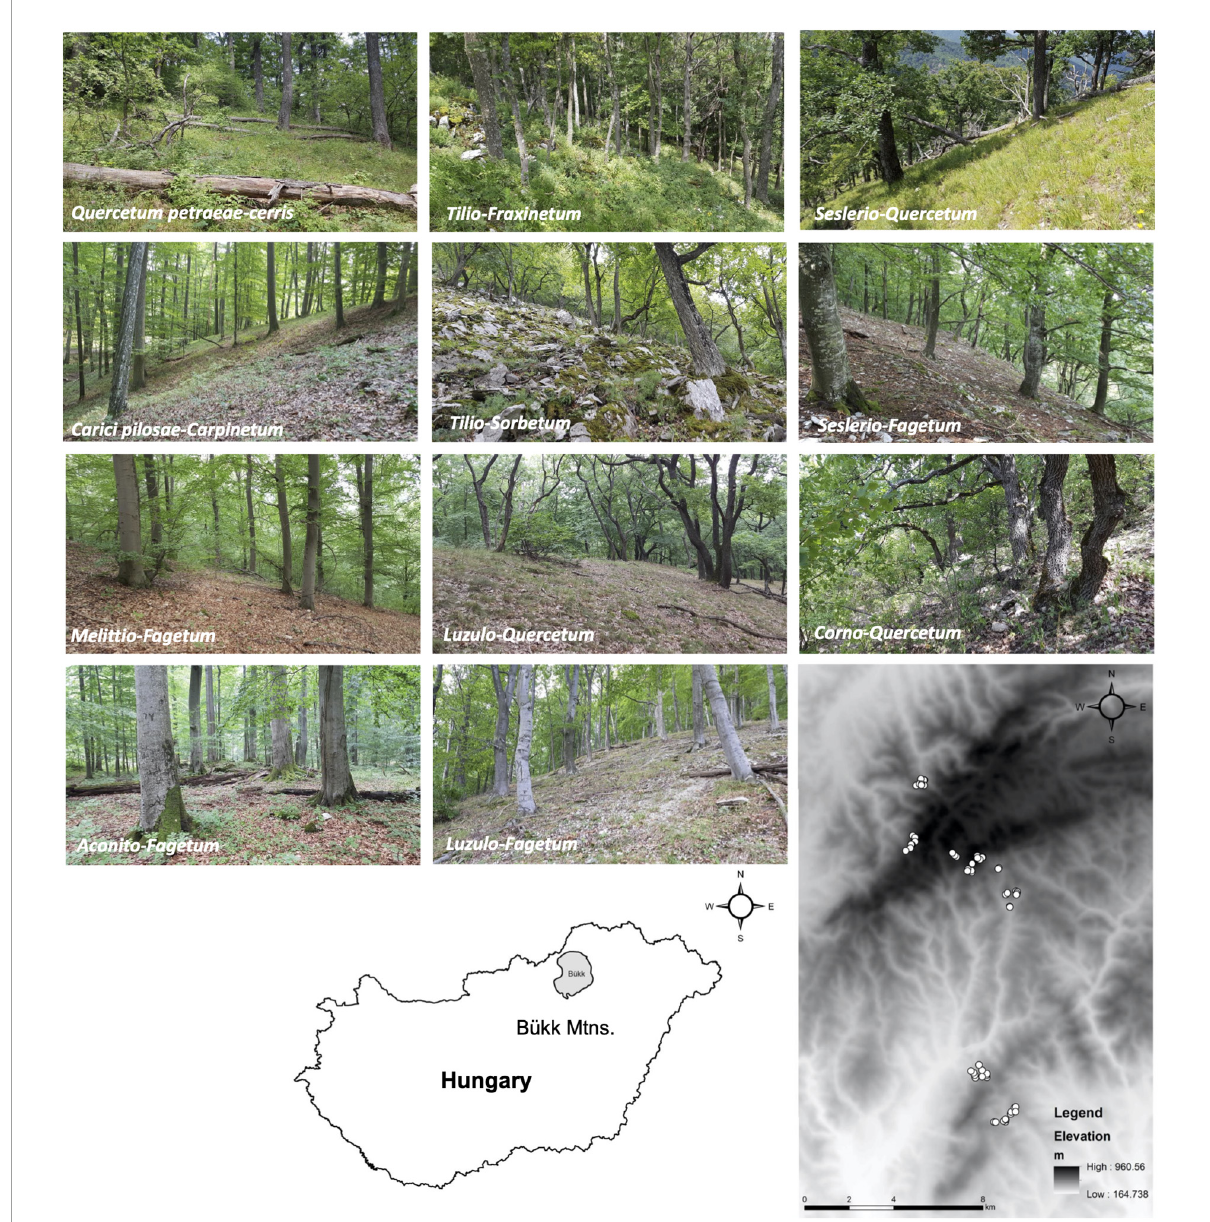
FIGURE1 Illustrations of the sampled forest types and a map of the sampling localities, with the location of the region of study in Hungary. Full names and a brief ecological summary of the forest types are given in Table 1 , while vegetation types, geographic coordinates, and abiotic variables corresponding to the sampling localities are listed in Supplementary Table 1